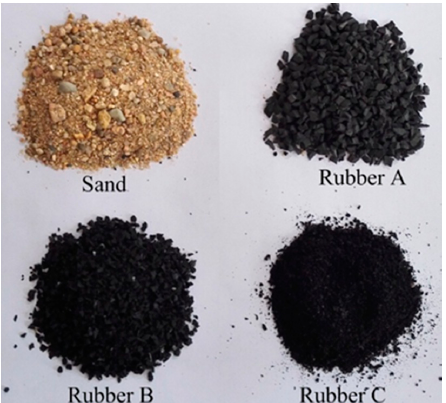
Figure 1. Fine aggregates: Sand, Rubber A, Rubber B, and Rubber C.